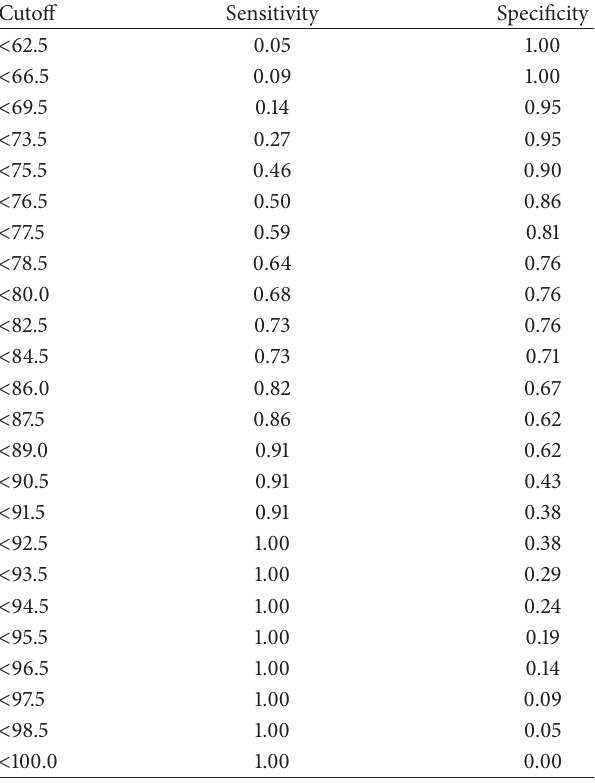
Table 4: Sensitivity and specificity of ACE-R for detecting PD-MCI at different cutoff